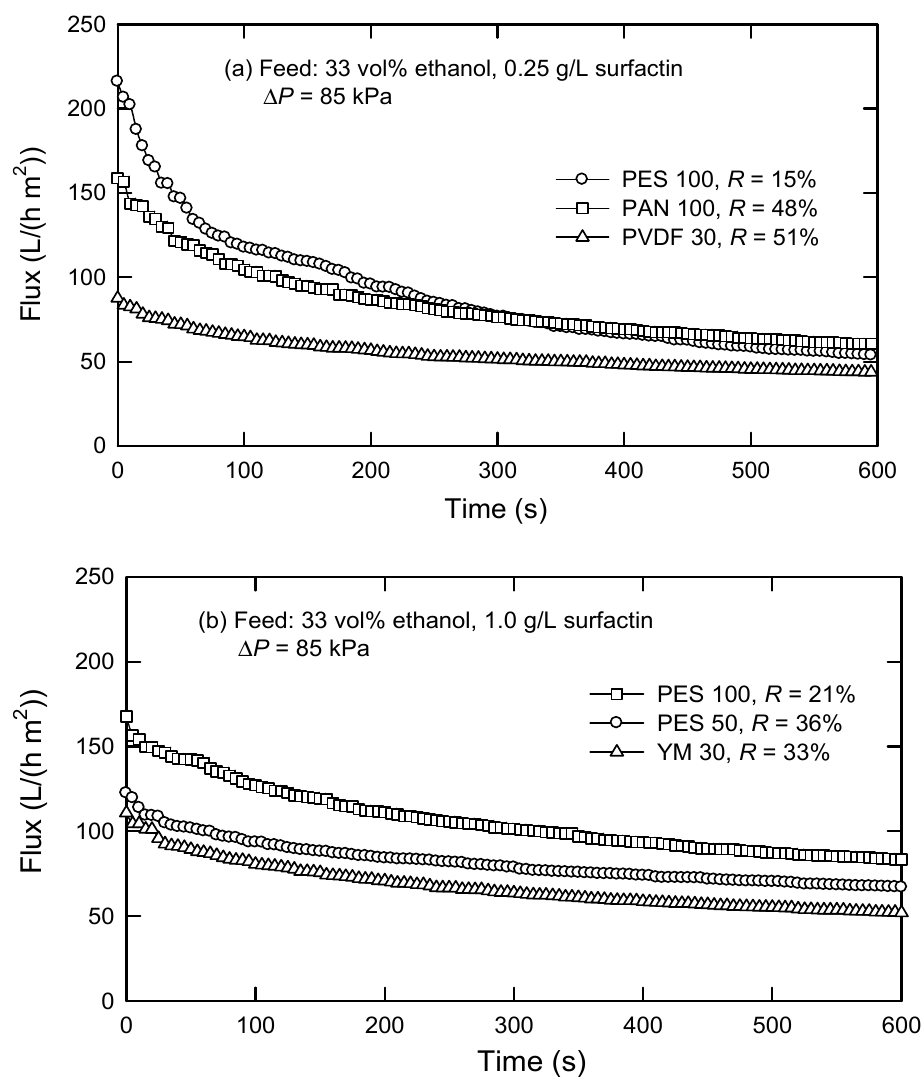
Figure 3. Flux decline and surfactin rejection in the presence of 33 vol% ethanol and a feed surfactin concentration of ( a ) 0.25 g/L and ( b )1.0 g/L by dead-end UF.